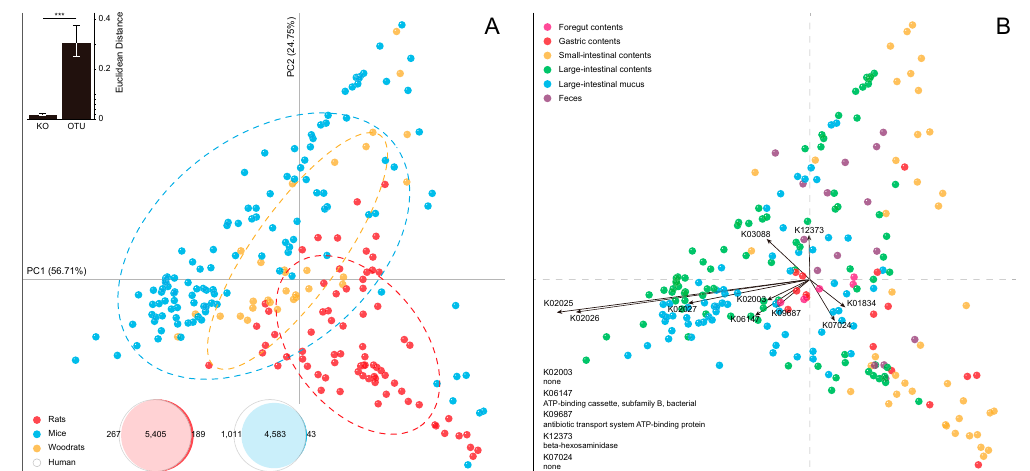
Figure 3. The similarities and differences in metabolic potentials among the GI microbiomes from different hosts: the PCA based on the KO profiles of GI microbiome used 227 samples form mice, rats and woodrats, grouped by ( A ) host genotype (adonis: R 2 = 0.27; p ≤ 0.001) and ( B ) anatomic region ( R 2 = 0.09; p ≤ 0.001) in different colorations. The percentages of variation explained by PC1 and PC2 are listed along the axes representing them. The top 10 KOs driving the difference are indicated in panel ( B ). In panel ( A ), the normal confidence ellipses cover 67% of the samples belonging to the corresponding hosts. The insert graph on the upper left summarizes the Euclidean distances between samples from the same region but different hosts, calculated from KO profiles and OTU abundances respectively. The bar height represents the median inter-sample distance and the error bars range from the 25th to 75th quantile. The insert graph on the lower left shows the Venn diagrams demonstrating the functional overlaps between different mammalian hosts in the large-intestinal mucosal microbiome.